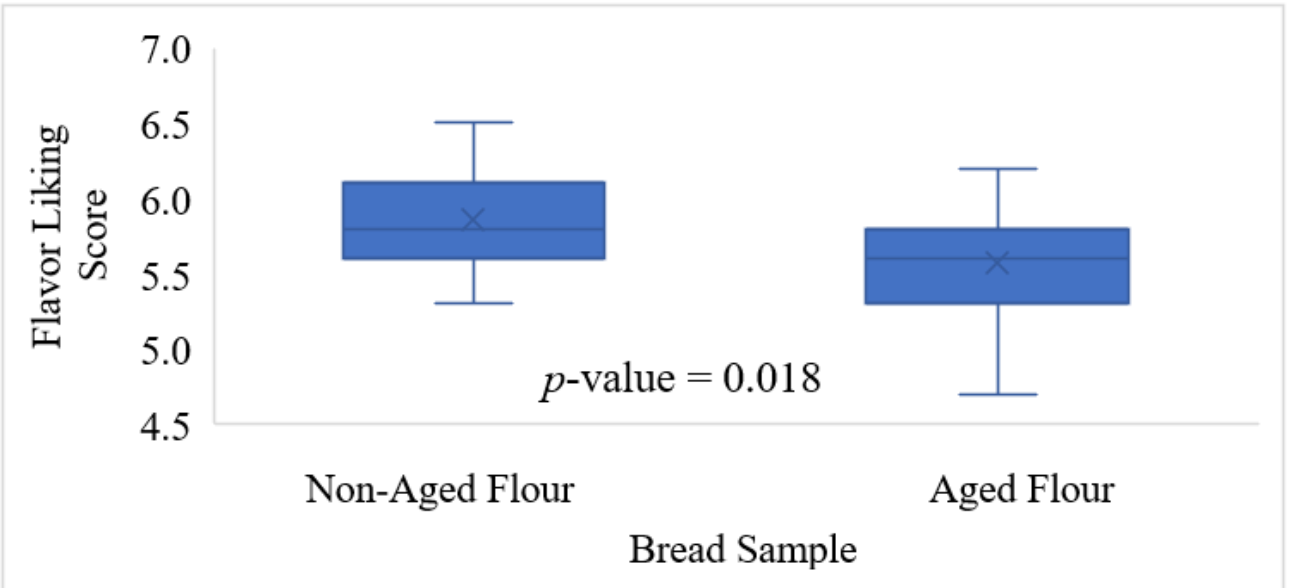
Figure 1. Average consumer flavor liking scores (1–9) of whole wheat bread samples ( n = 97) made with non-aged and aged whole wheat flour. Boxplots present the median correct responses (solid line in the middle), upper and lower quartiles, mean correct responses (X marks), minimum correct responses (lower whisker), and maximum correct responses (upper whisker). The significant difference was assessed using Student’s t -test.